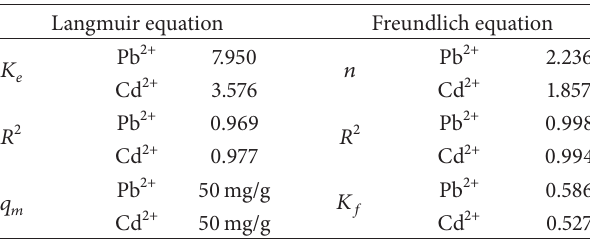
Langmuir equation Freundlich equation